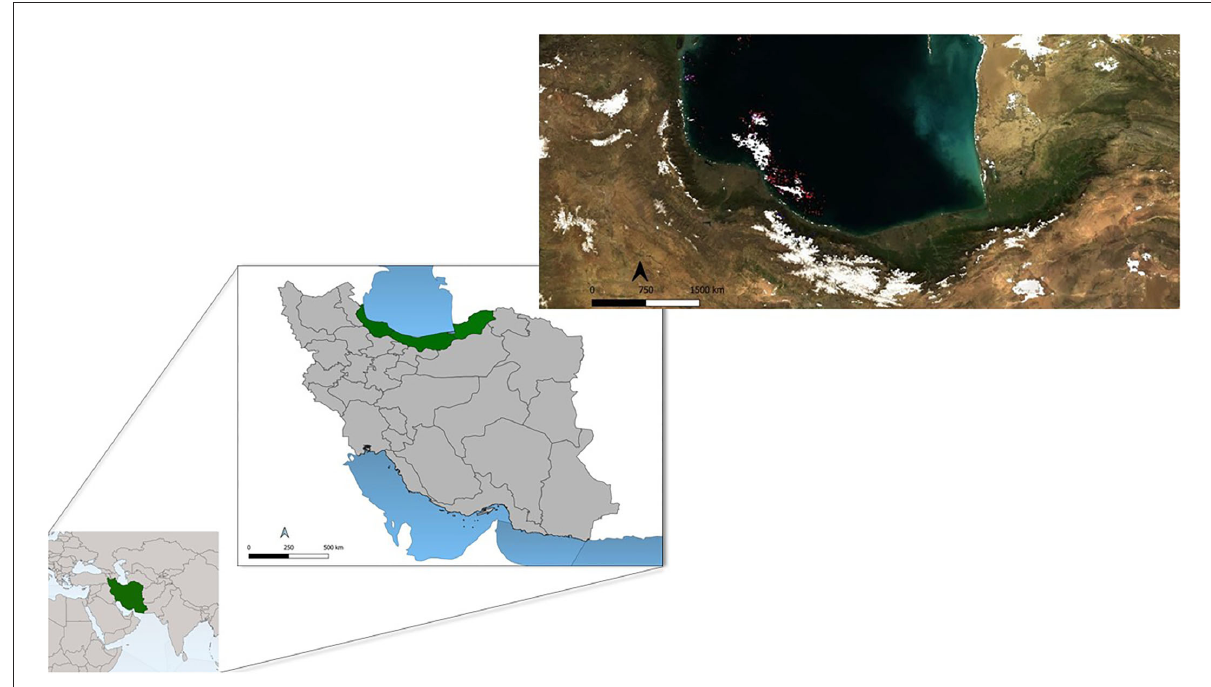
FIGURE3 Map of Iran highlighting the three provinces in northern Iran include: Mazandaran, Gilan, and Golestan provinces using QGIS V.3.18 and true-color Sentinel-2 satellite imagery from https://www.sentinel-hub.com/.